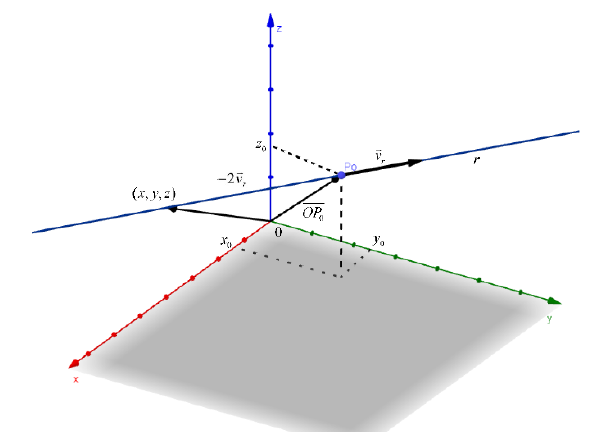
( ) 2 λ= − . Figure 18. Geometric interpretation of the line equation in vector form ( λ = − 2 ) .